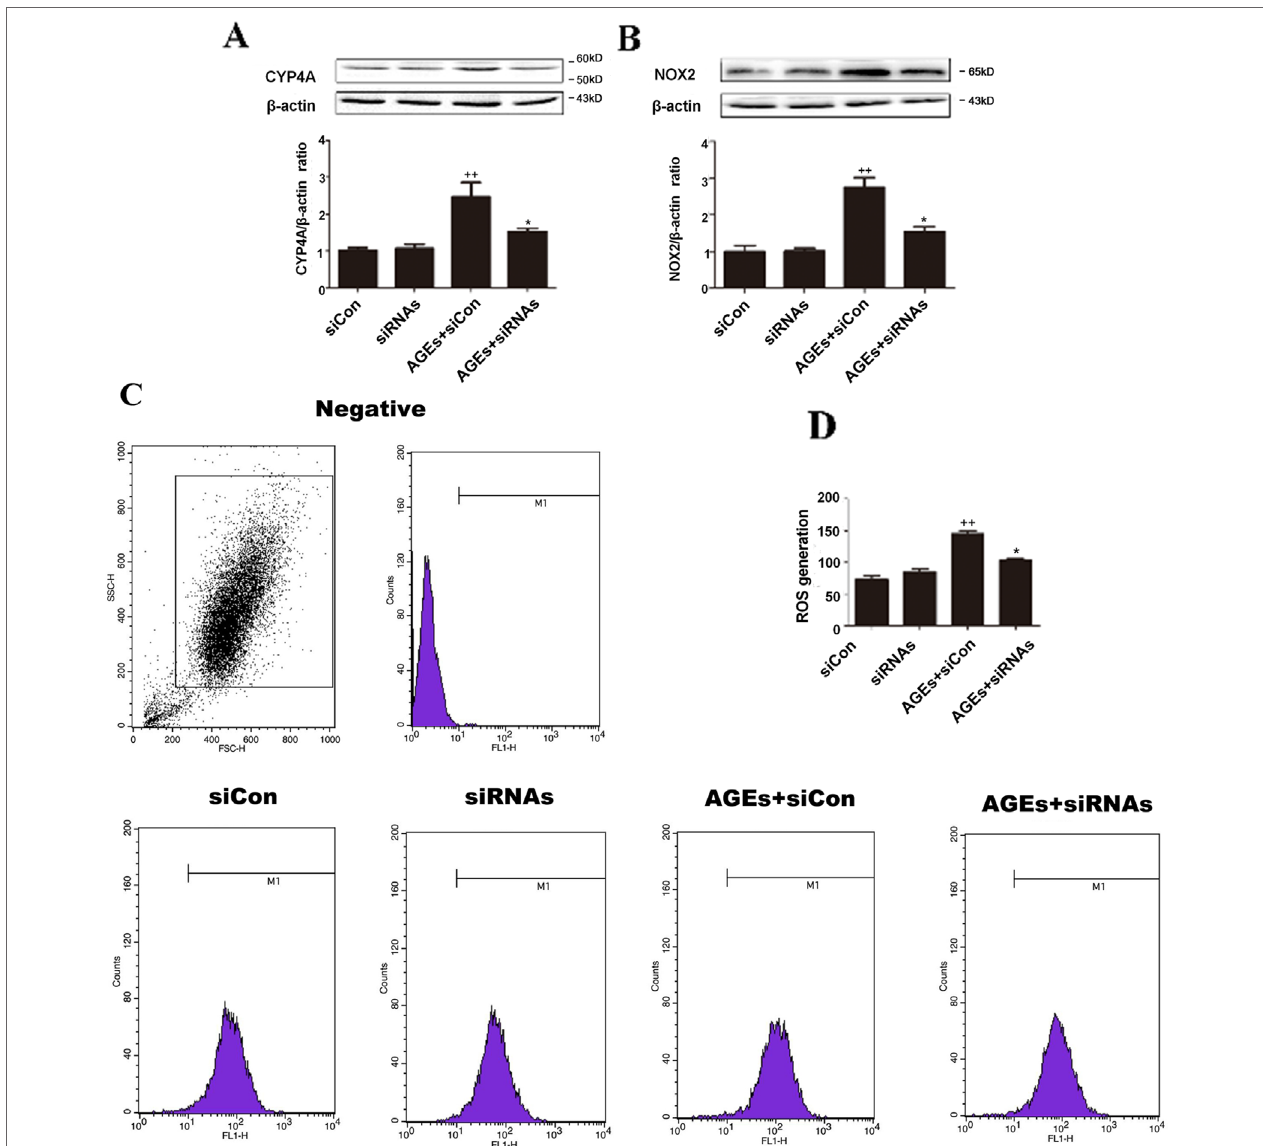
FIGURE 5 | Inhibition of CYP4A by siRNAs protects H9c2 cells from AGEs-induced oxidative stress. (A) Protein expression of CYP4A. (B) Protein expression of NOX2. (C) Level of ROS generation. (D) A summary of flow cytometry analyses of cells stained with DCFH-DA. n = 3. siCon: siControl. siRNAs: siRNAs against CYP4a1, CYP4a2, and CYP4a3. H9c2 cells at a density of 1 × 10 5 cells per well were seeded on six-well plates and transfected at 70–80% confluence with siRNAs against rat CYP4a1, CYP4a2, CYP4a3, or nonbinding control siRNA. Transfection was performed with Lipofectamine 2000. After 24 h of Cyp4a siRNAs transfection, cells were treated with 10 μ M AGEs or BSA for 24 h. Compared with the siCon group, ++p < 0.01; compared with the AGEs+siCon group, *p < 0.05, **p < 0.01 (one-way ANOVA with Tukey post hoc